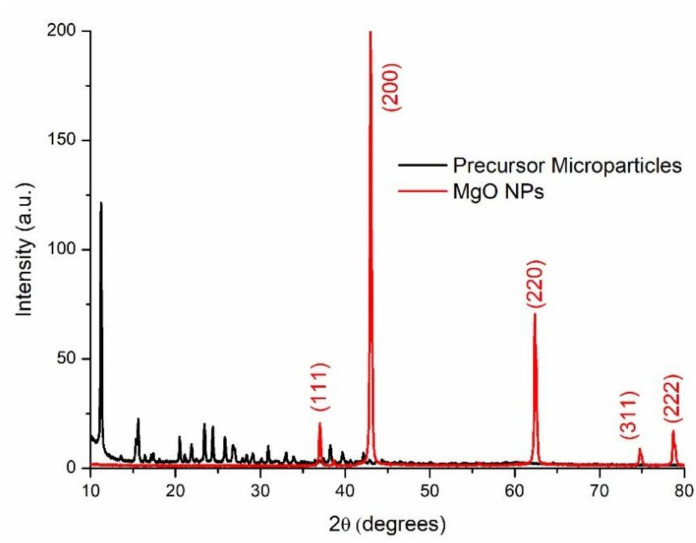
Figure 3. X-ray diffraction patterns for PM and MgO